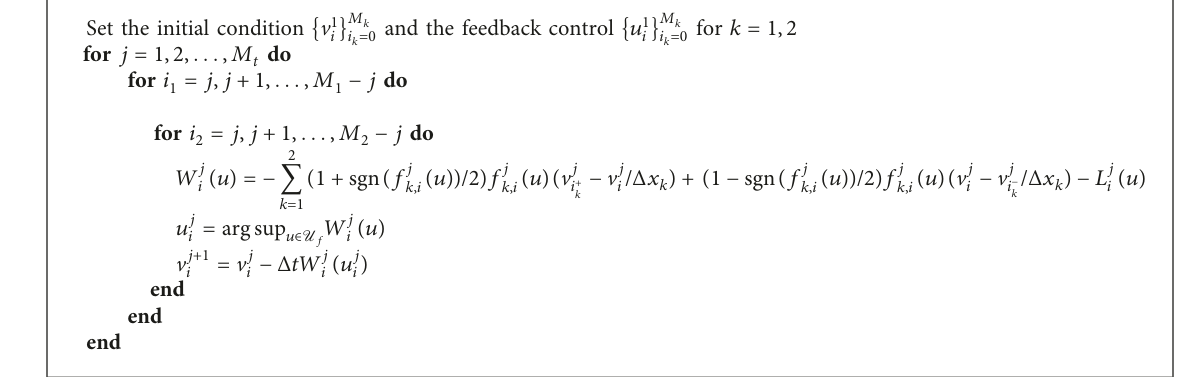
A LGORITHM 1: Algorithm for solving HJB